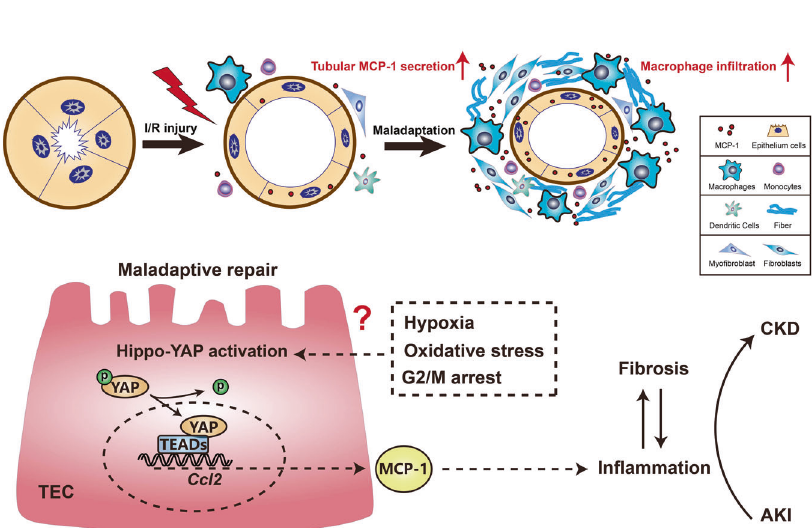
Fig. 8 Schematic diagram of YAP-MCP-1 mediating the crosstalk between tubular maladaptation and interstitial in fi ltration. Following ischemic AKI, YAP activation in tubular epithelial cells causes MCP-1 overexpression and promotes renal macrophage in fl ammation, which is a driven force for progressive fi brosis and AKI-CKD transition. In addition, hypoxia, oxidative stress, and cell cycle G2/M arrest might be the keys to activate YAP persistently in maladaptive-repaired tubular epithelial